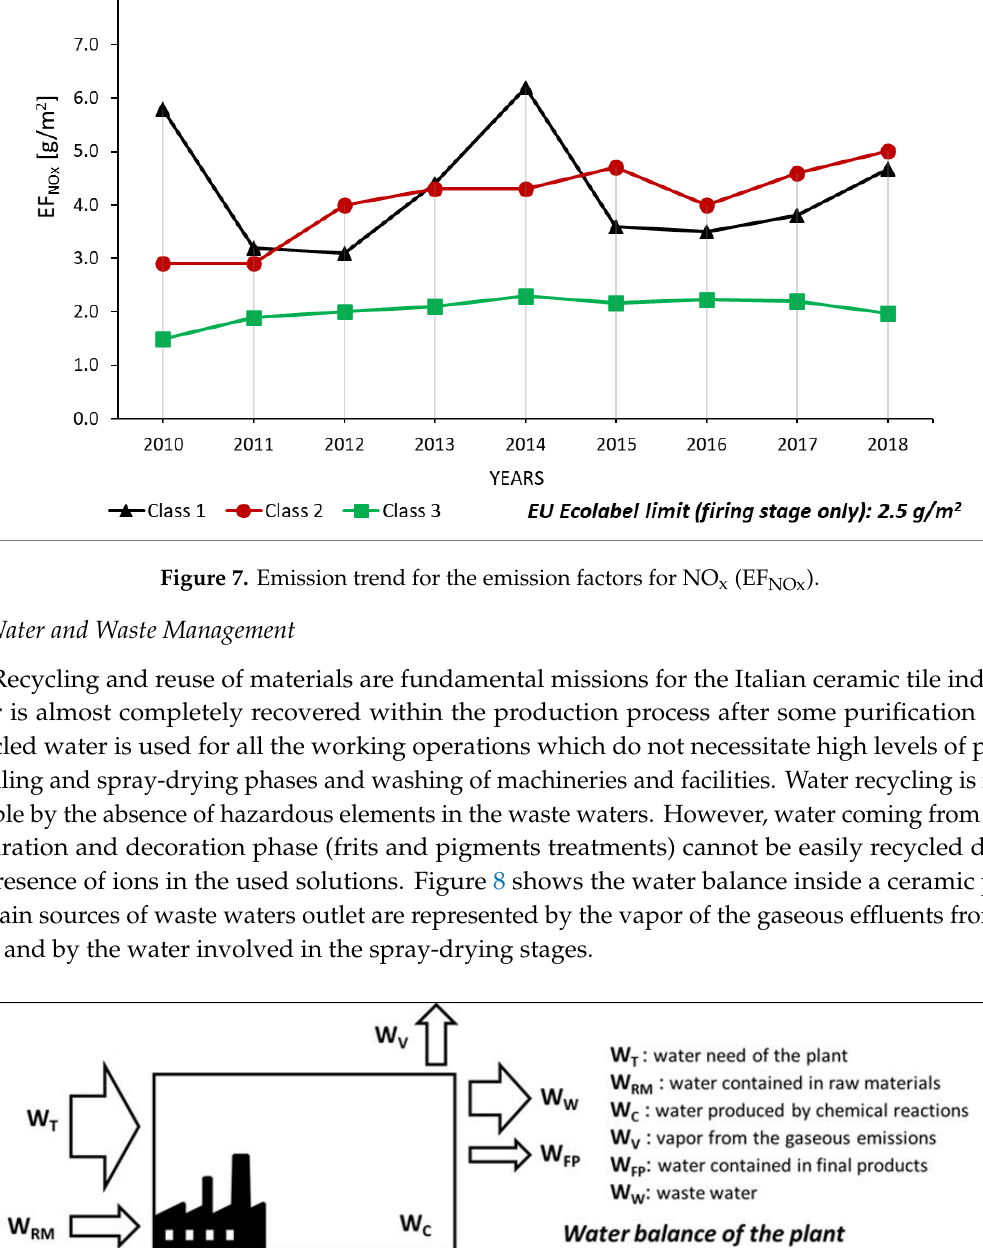
Figure 8. Scheme of the water balance of a ceramic tile plant.